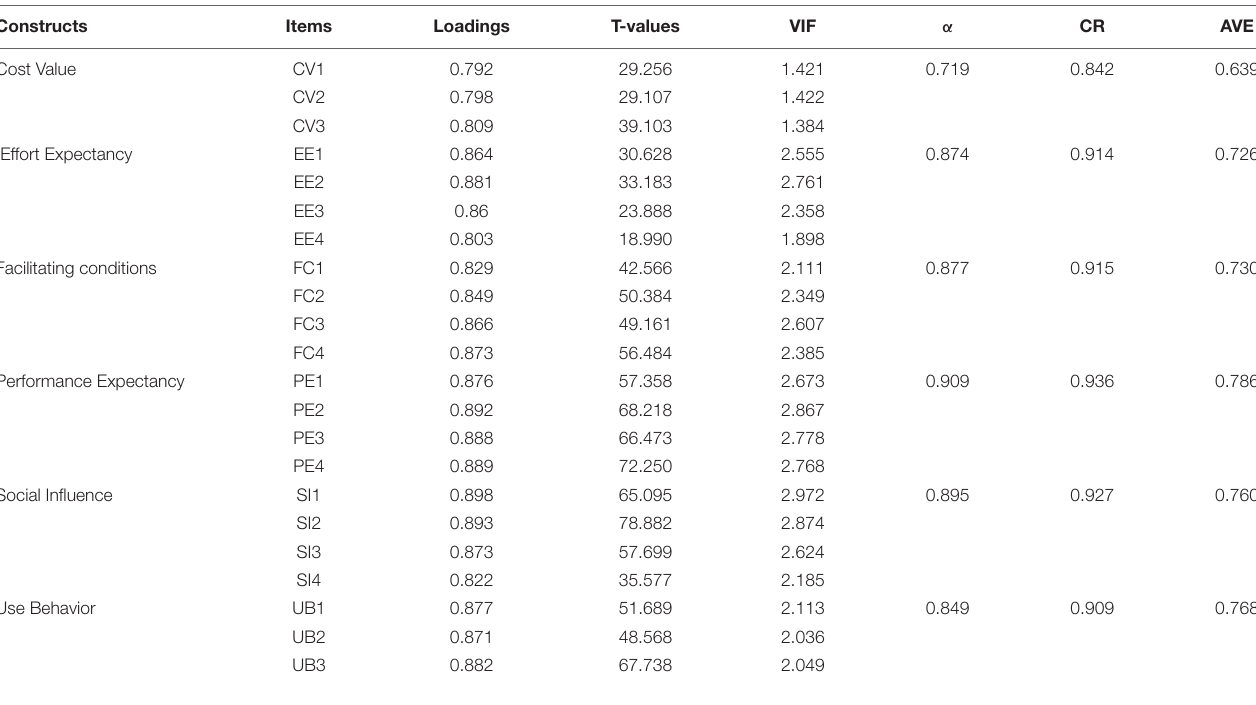
TABLE 2 | Reliability and validity